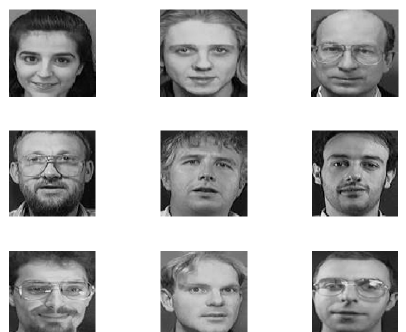
Figure 5. Sample facial images from Research Laboratory for Olivetti and Oracle (ORL) database used as original biometrics [25].